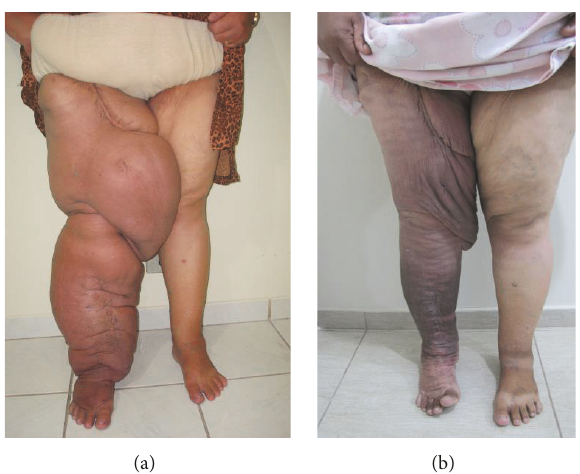
Figure 1: (a) and (b) illustrate initial treatment and treatment after 5 days in a secondary